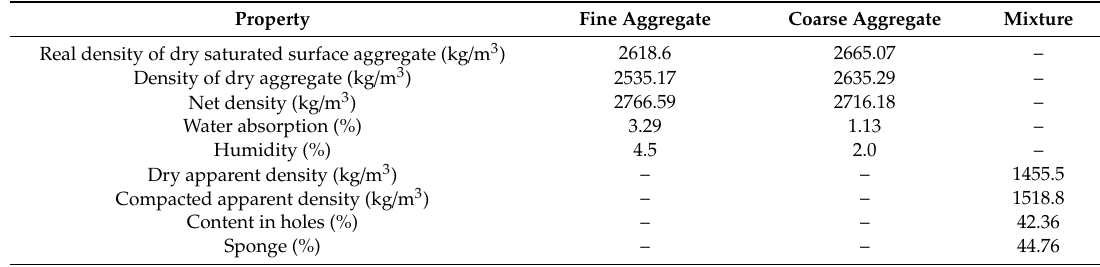
Table 1. Properties of a sample type of concrete manufactured for the